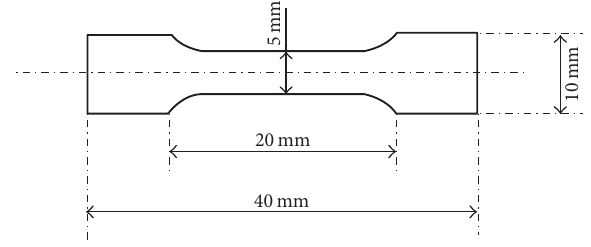
Figure 2: The sample diagram of tensile test.